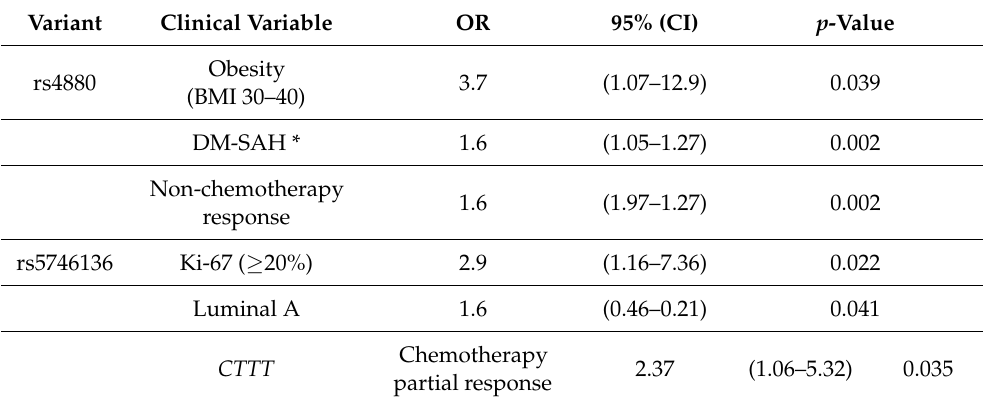
Table 5. Association of the rs4880, and rs5746136 variants of SOD2 with clinical variables of BC patients.